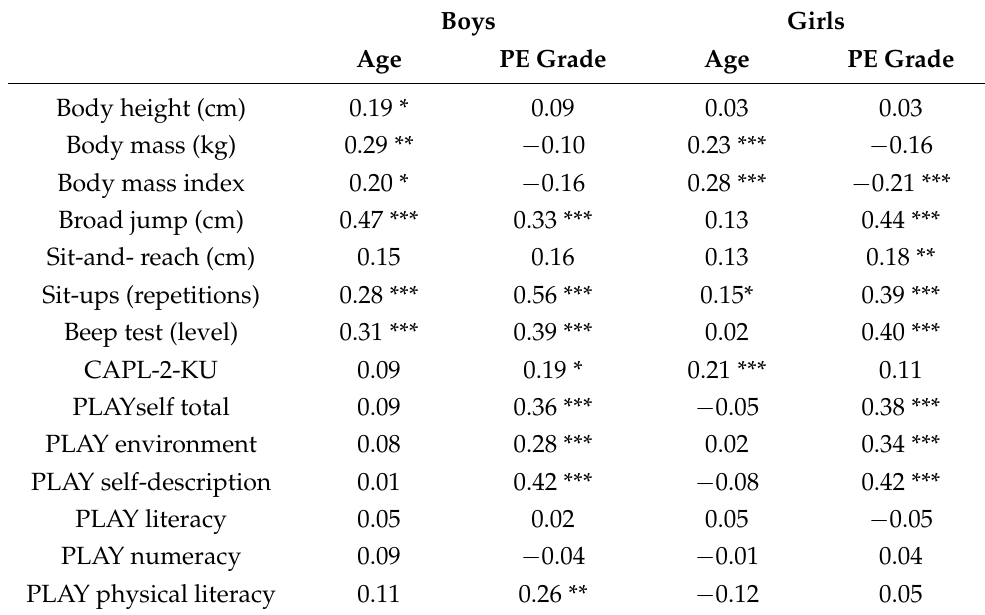
Table 3. Correlations between study variables and participants’ age and PE